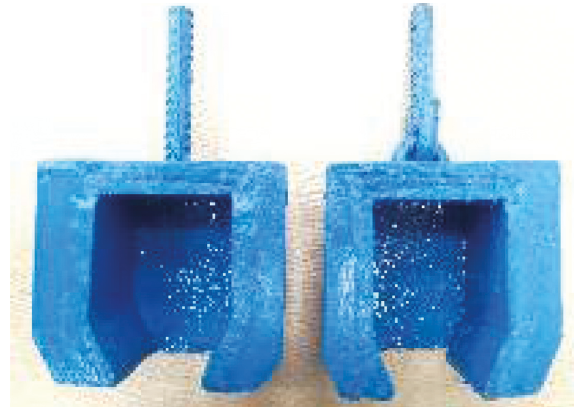
Figure 4: Special fixtures used in the uniaxial tensile test.